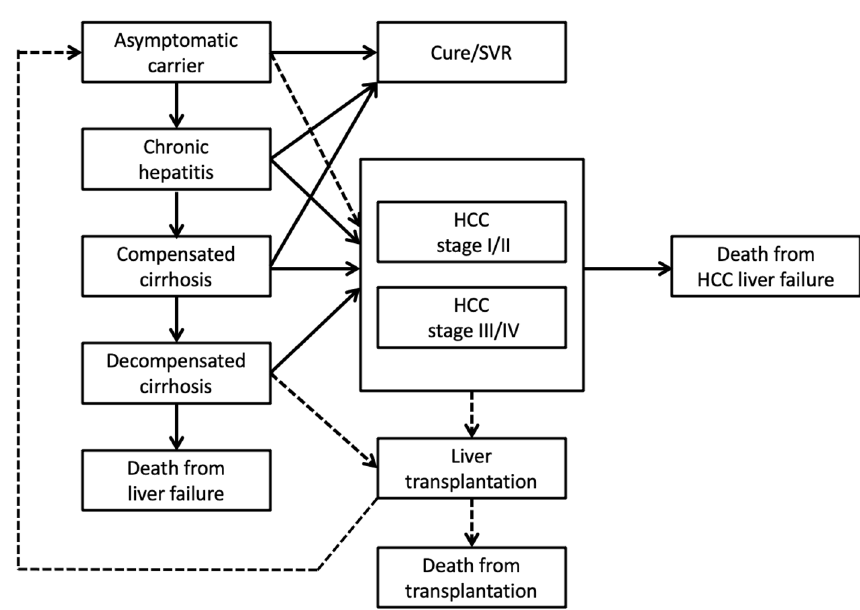
Figure 3. Model structure of chronic hepatitis C-related